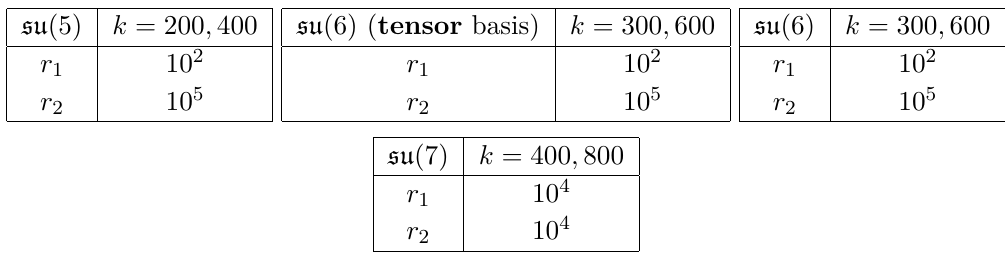
Table 2 . The scaling factors for L 26